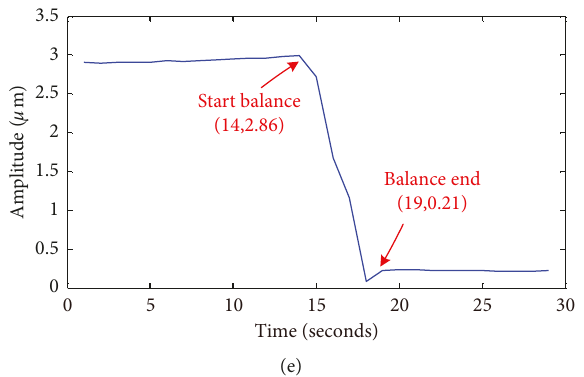
Figure 19: Comparison of balance information in the X - Y direction at 12,000rpm. (a) X -time domain. (b) Y -time domain. (c) X -frequency domain. (d) Y -frequency domain. (e) Online balance